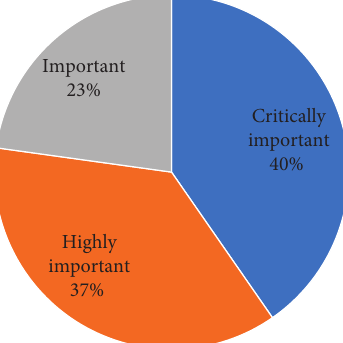
Figure 3: Categorisation of farmers’ use of antimicrobials based on the WHO criteria for ranking antimicrobial drug use in human medicine ( n �